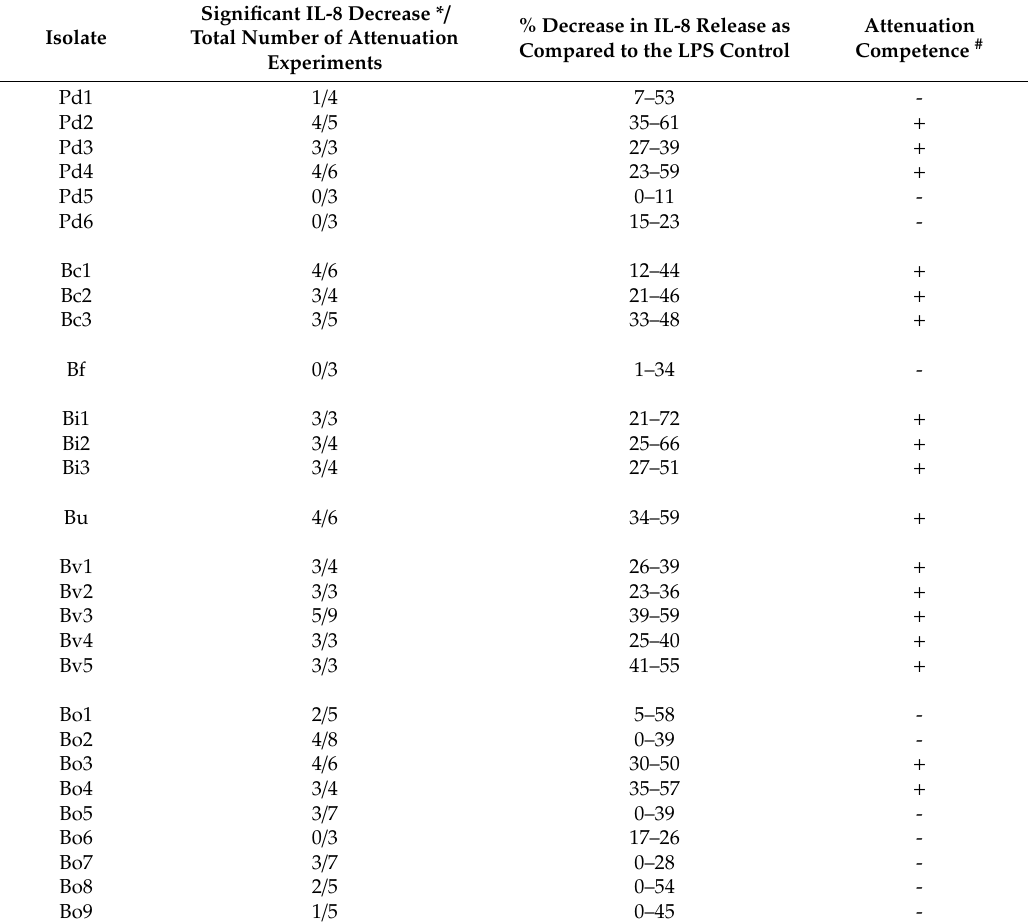
Attenuation Competence #